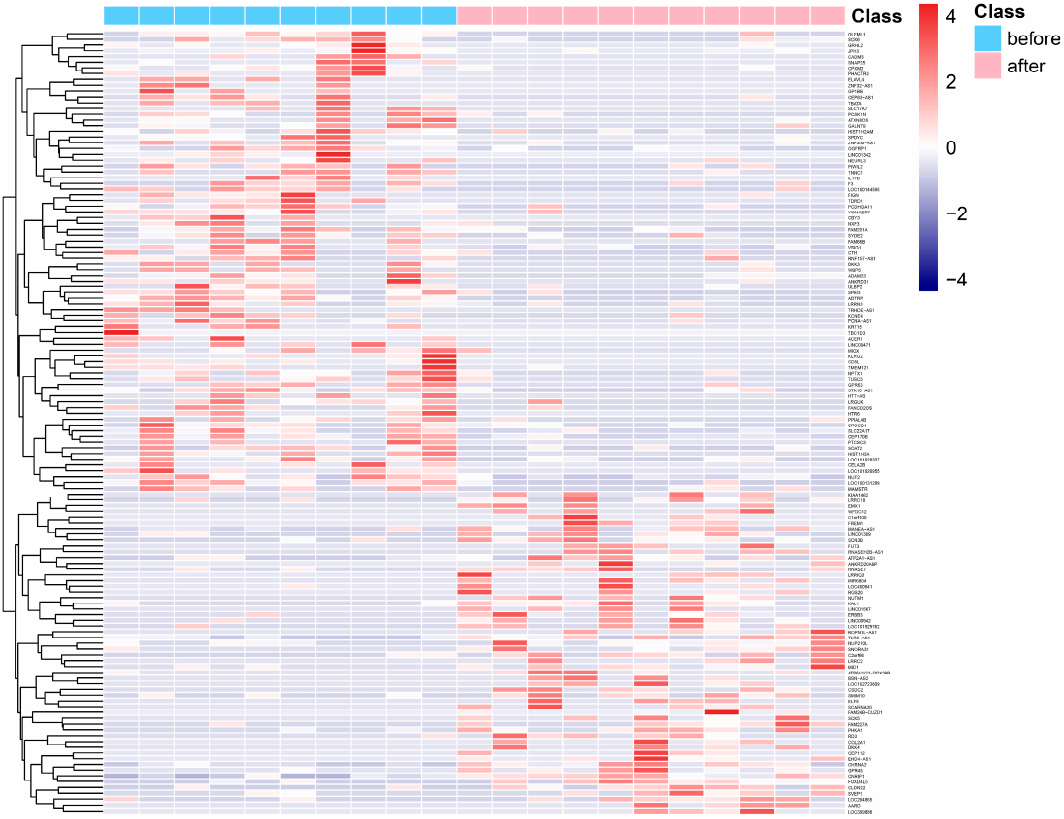
Figure 1. Heatmap shows differentially expressed genes (DEGs) before or after 12-week Tai Chi exercise; red represents highly expressed genes, and blue represents lowly expressed